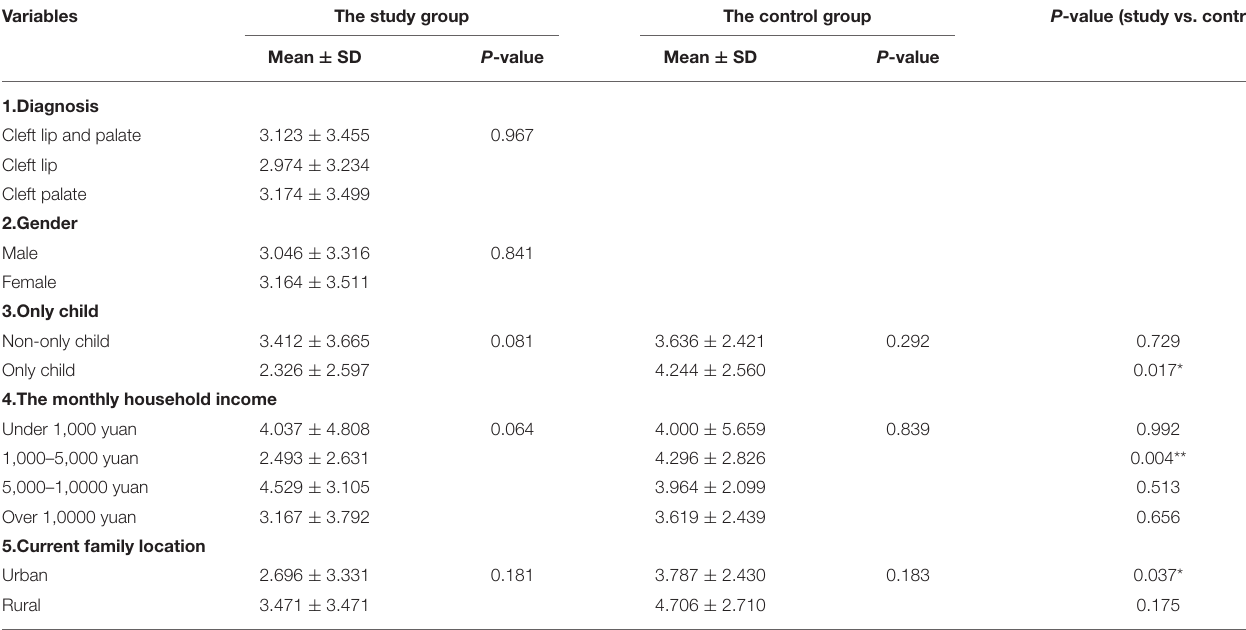
TABLE 4 | Factors affecting anxiety status of Chinese patients with CL/P. Variables The study group The control group P -value (study vs.